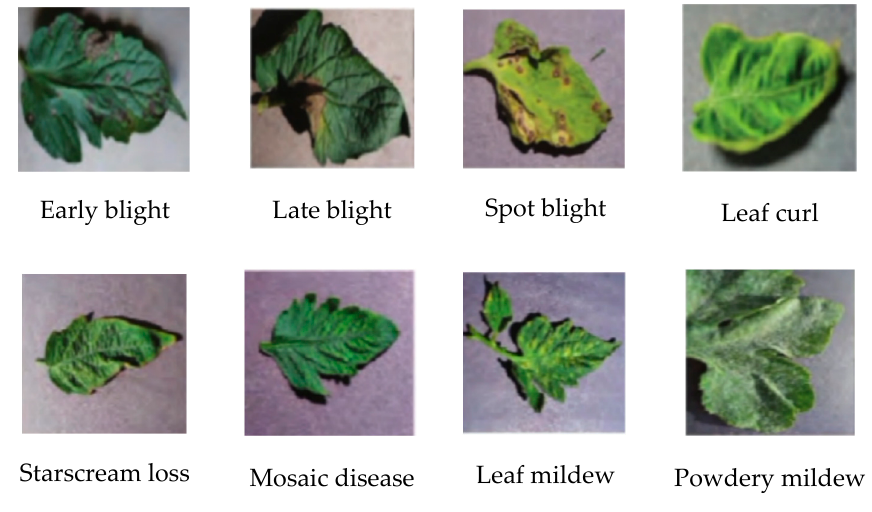
Figure 7. The eight tomato diseases.